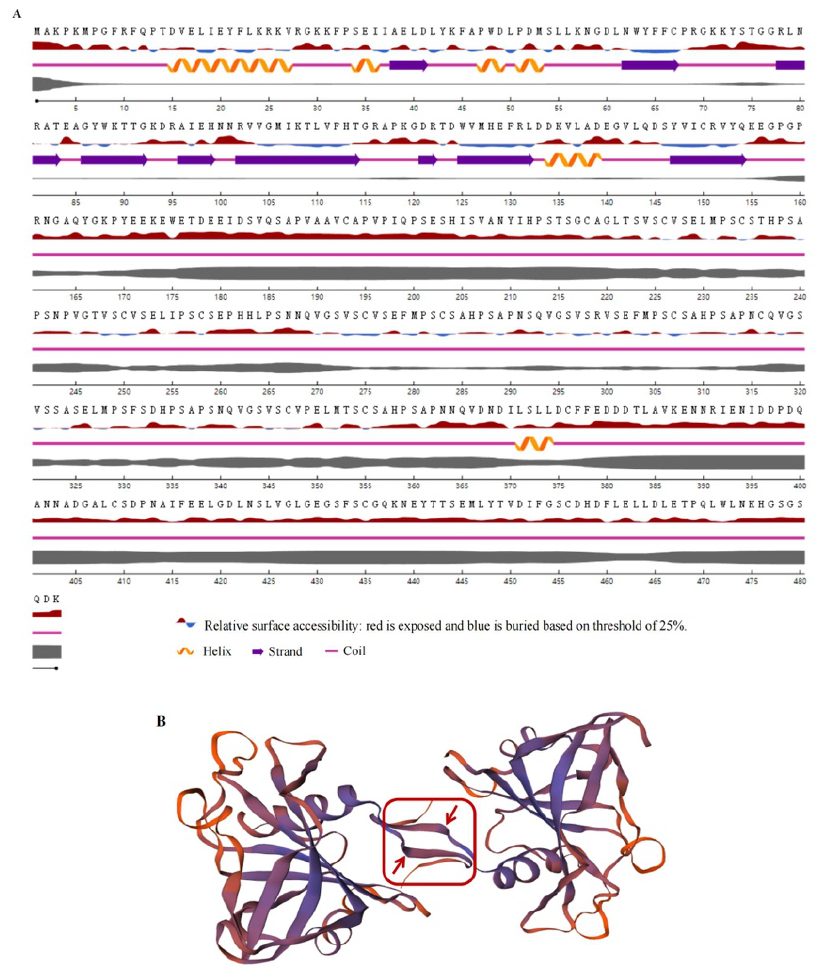
Figure 2. Secondary and tertiary structures of GmNAC3 protein. ( A ) Secondary structure of GmNAC3 protein based on NetSurfP-3.0. Thickness of line represents the probability of disordered residue. ( B ) Tertiary structure of GmNAC3 protein dimer based on and SWISS-MODLE. The red box circumscribes the antiparallel β -sheets forming dimerization interface indicated by red arrows. The results of a basic local alignment search tool (BLAST) search based on the GmNAC3 protein sequence identified a total of 15 protein sequences, with the highest homologous similarities to the GmNAC3 protein in the NCBI database (https://blast.ncbi.nlm.nih.gov/; accessed on 12 July 2022). The phylogenetic tree was con- structed based on these protein sequences using the neighbor-joining method (Figure 3).